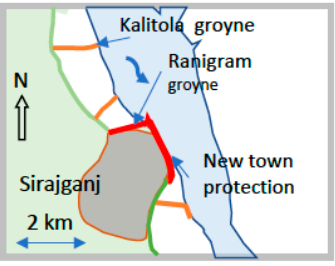
Figure 2. Head of the Ranigram groyne and the new town protection of Sirajganj. Legend: red = Ranigram groyne, revetment, brown = groynes, green = embankment, light green = land protected by embankment, blue = low water channnel of the Brahmaputra-Jamuna in 2018, grew = Siraiganj town. The existing revetment of the Sirajganj town protection and the new Ranigram groyne was at risk of failure after the devastating monsoon floods in 1988 and 1989. The Sirajganj town protection is part of the more than 200-km-long Brahmaputra Right Flood